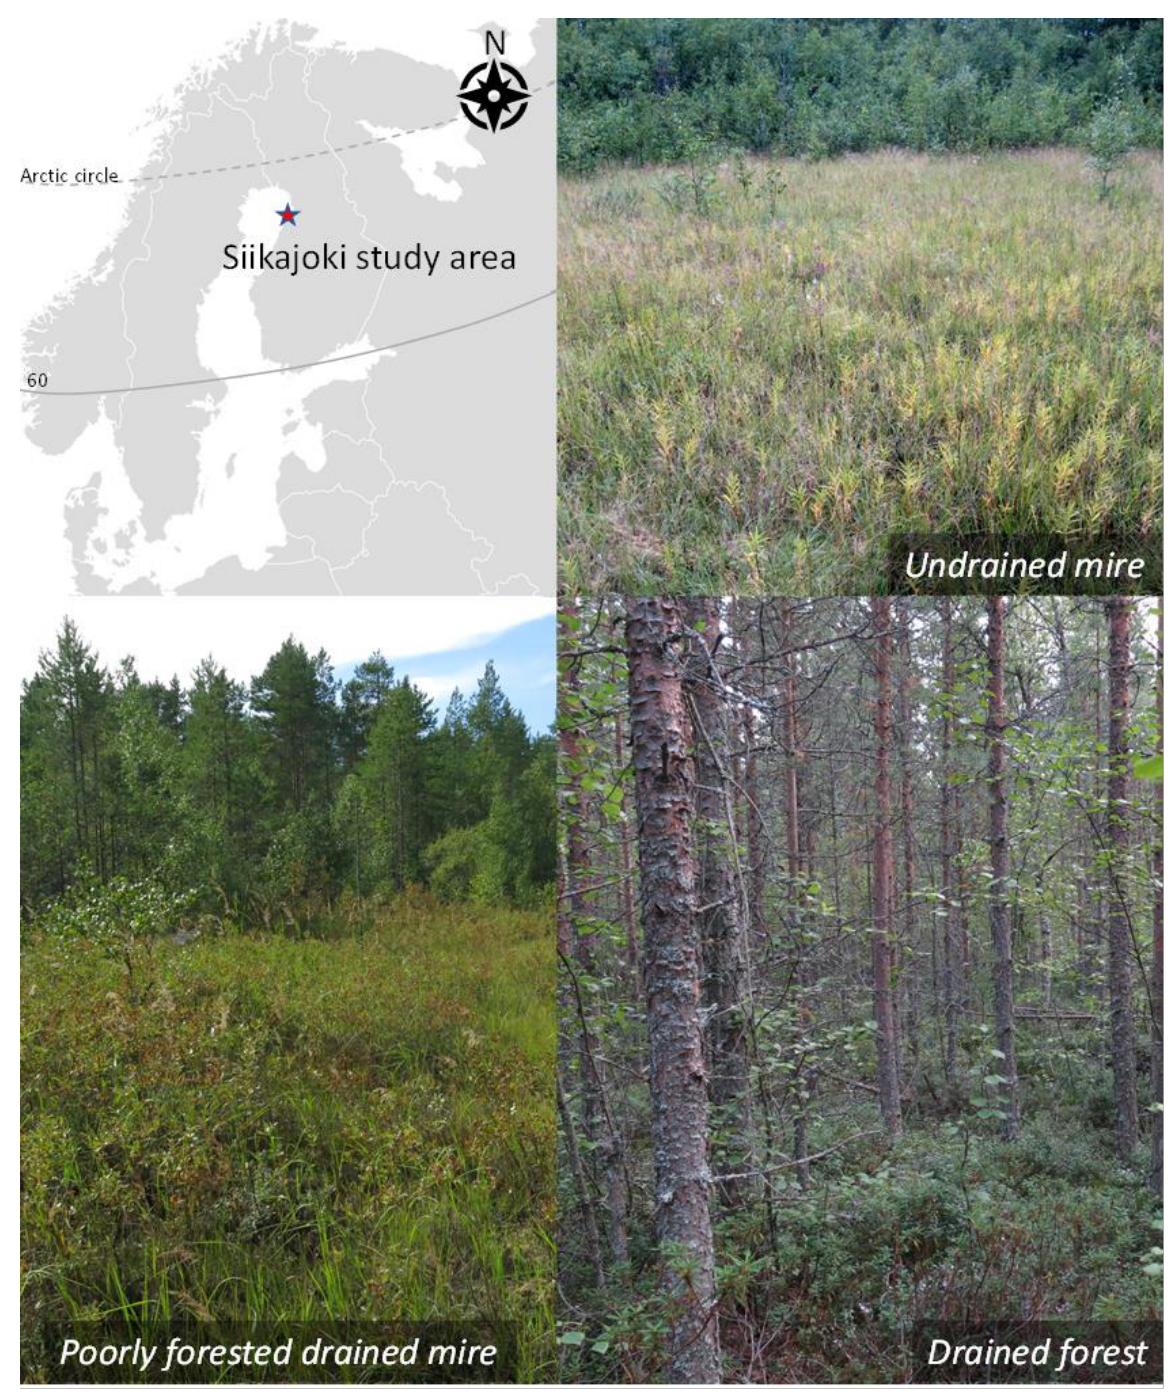
Figure 1. Map showing the study area, Siikajoki, Finland and photographs of the Undrained mire , Poorly forested drained mire and Drained forest